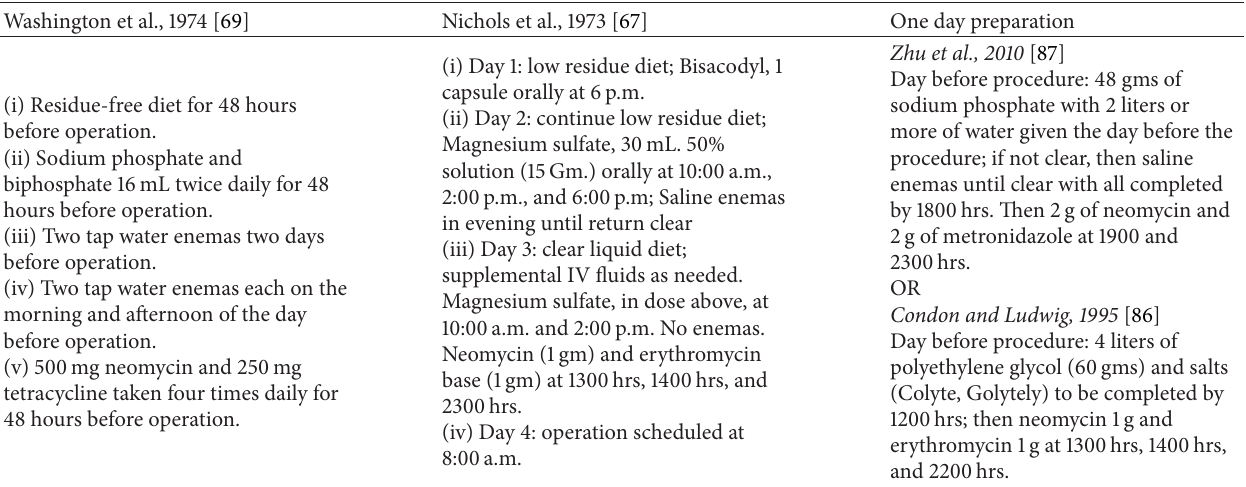
Table 6: Demonstrates the choices of mechanical bowel preparation that has been employed in those studies where the oral antibiotic bowel preparation has been demonstrated to be effective. There are many variations on these protocols. Washington et al., 1974